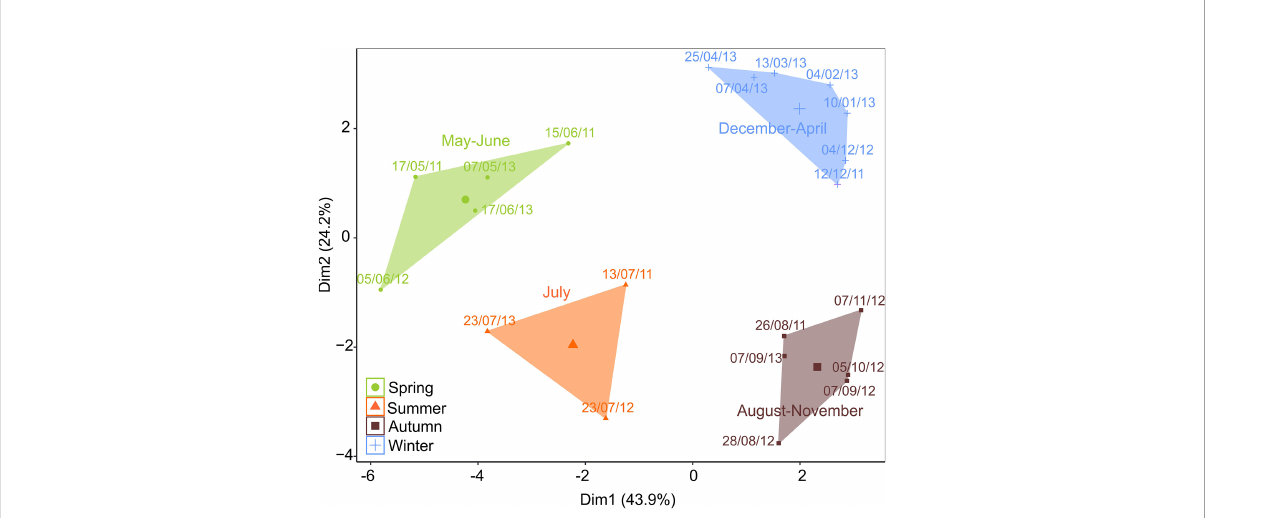
FIGURE 4 Multidimensional scaling (MDS) of cluster analyses performed on integrated (log x + 0.1 transformed) zooplankton species/taxa data (ind. m − 3 ). The two dimensions display 68.1% of the total variability and show four distinct clusters of samples with high similarity (>69%; SIMPER):